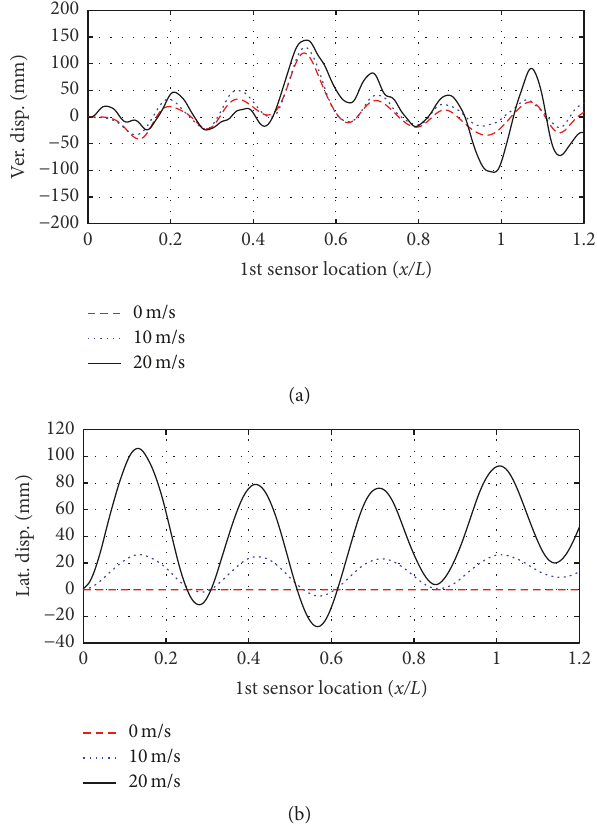
Figure 18: Time history responses of the Skytrain Bridge at center under various wind velocity (vehicle speed: 100km/h): (a) vertical displacement, (b) lateral